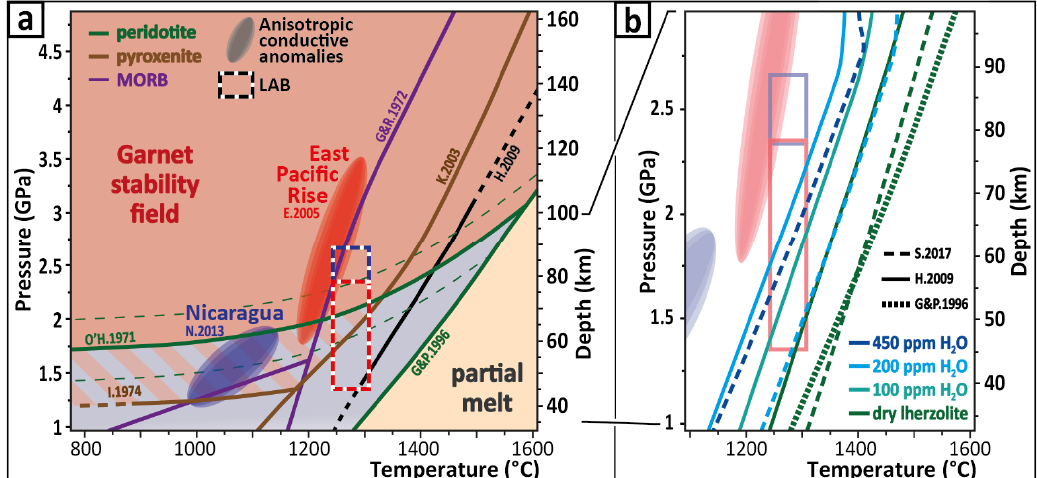
Figure 3. Correlation between electrical anomalies and garnet stability in mantle rocks. ( a ) Phase diagram showing the P-T conditions for the electrical anomalies offshore Nicaragua (dark blue) [3] and near the EPR (light red) [1] in accordance with Figure 1. ( b ) Impact of water content on the solidus (i.e., onset of melting) of lherzolite (i.e., fertile peridotite). In both ( a ) and ( b ), P-T conditions at the LAB are also indicated for comparison (dark blue and light red boxes). Solidus from [30] are extrapolated for temperatures between 1100 and 1300 ◦ C (plain lines). References: E.2005 = [1]; H.2009 = [30]; G&P.1996 = [31]; G&R.1972 = [32]; I.1974 = [33]; K.2003 = [34]; N.2013 = [3]; O.1971 = [35]; S.2017 =